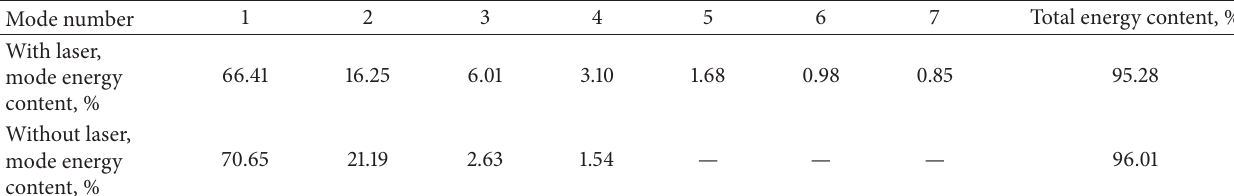
Table 1: Number of modes and energy contents.